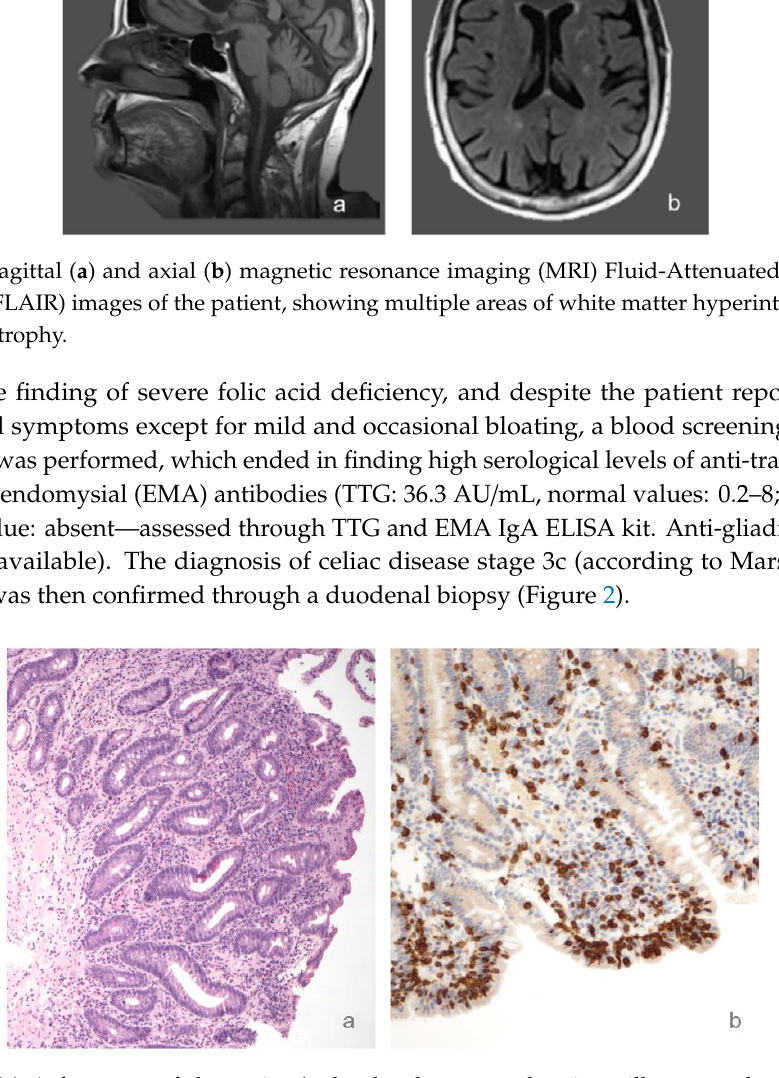
Figure 2. ( a ) A fragment of the patient’s duodenal mucosa showing villous atrophy, glandular crypt hyperplasia, low enterocytes height, irregular brush-border and cytoplasmic vacuoles; ( b ) CD3 immunohistochemical staining of the duodenal mucosa showing a pathological increase of intraepithelial lymphocytes.